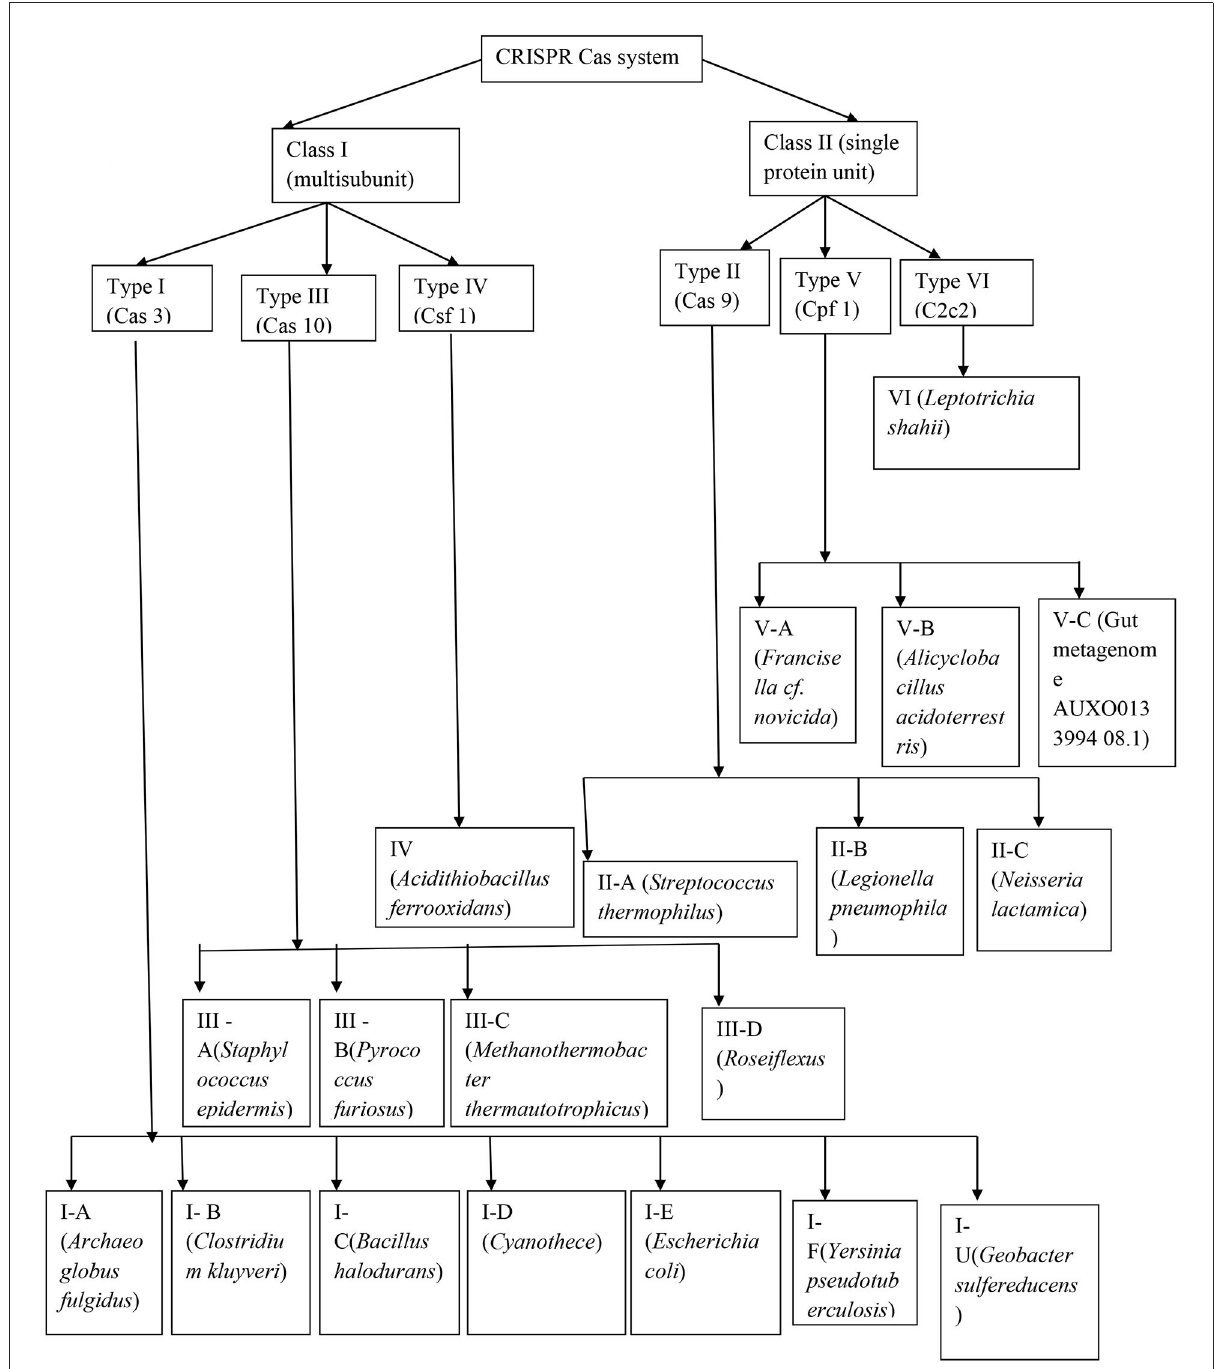
FIGURE1 Detailed structure of the CRISPR-Cas system.